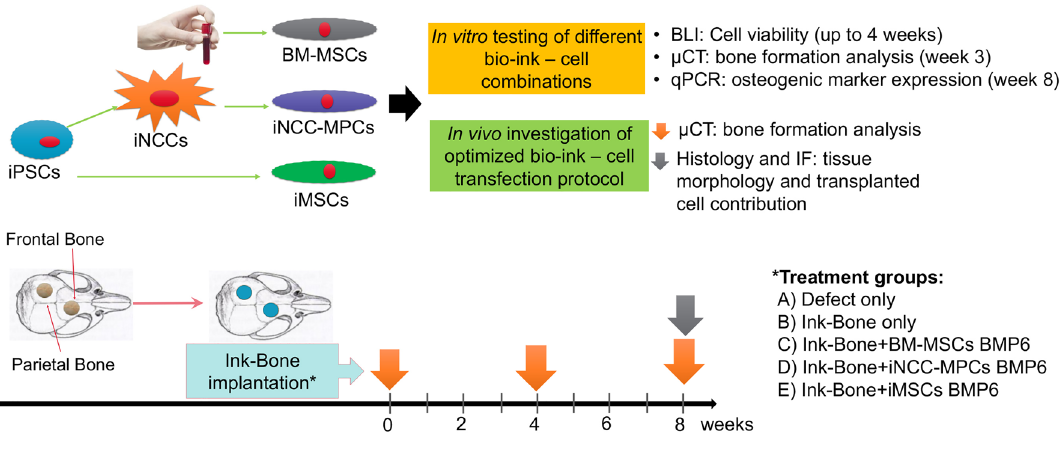
Figure 1. Graphical abstract and experimental